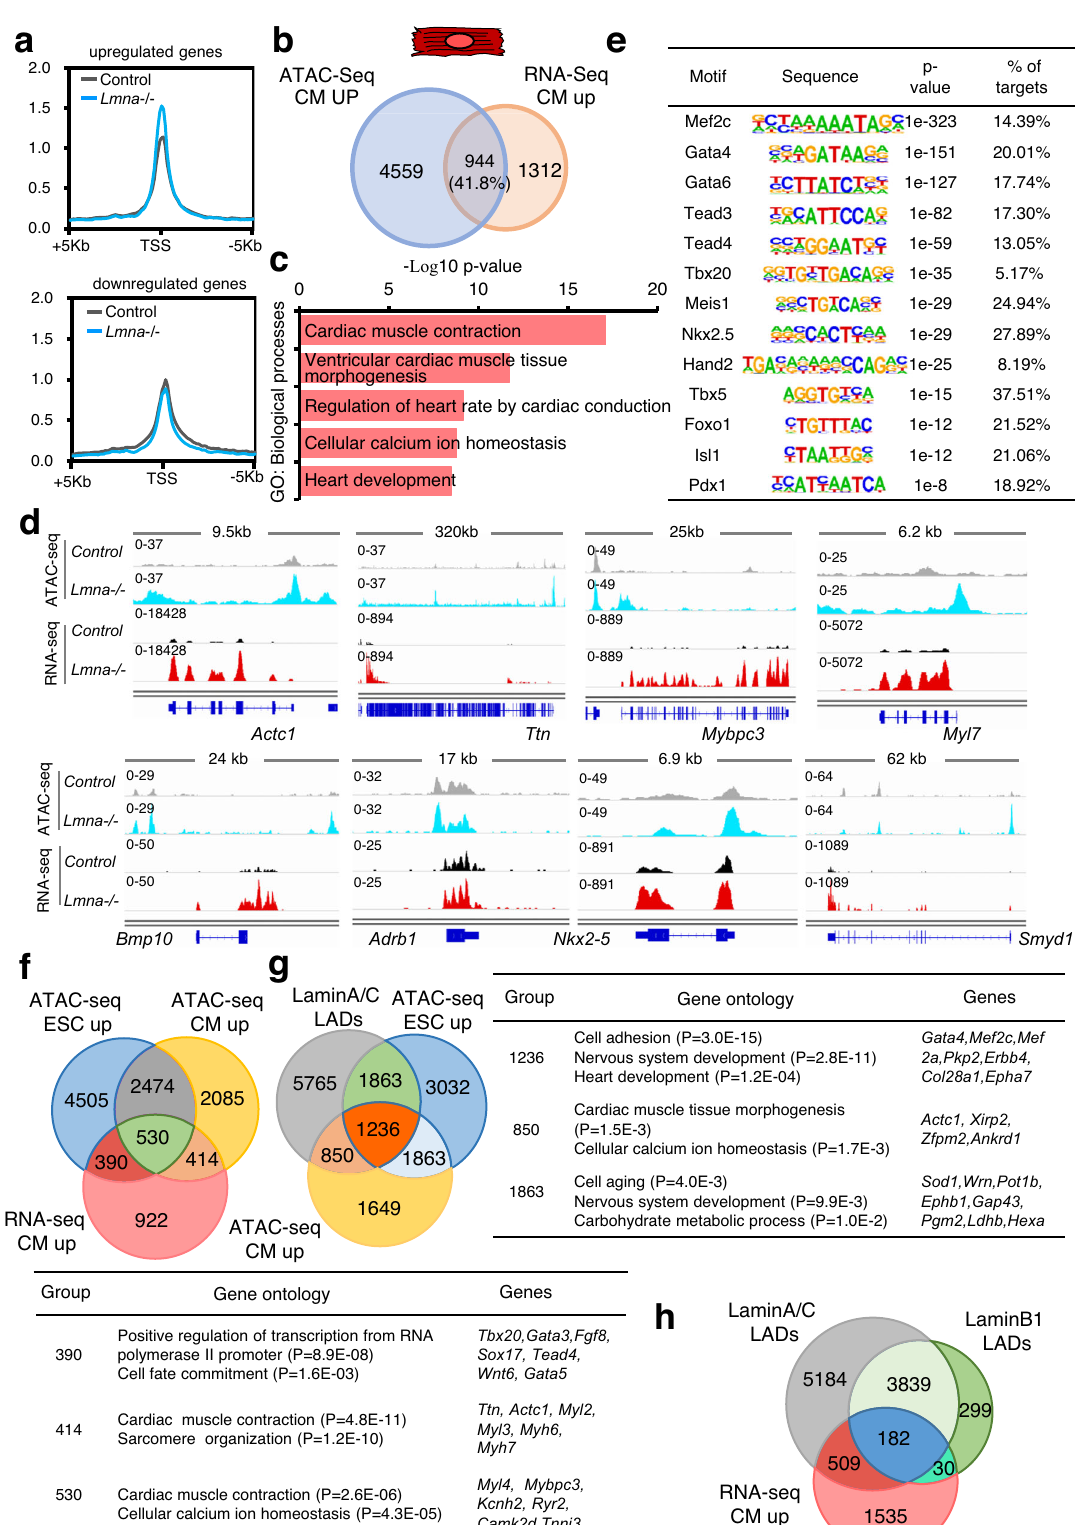
Actc1, Xirp2, Zfpm2,Ankrd1 Sod1,Wrn,Pot1b, Ephb1,Gap43, Pgm2,Ldhb,Hexa